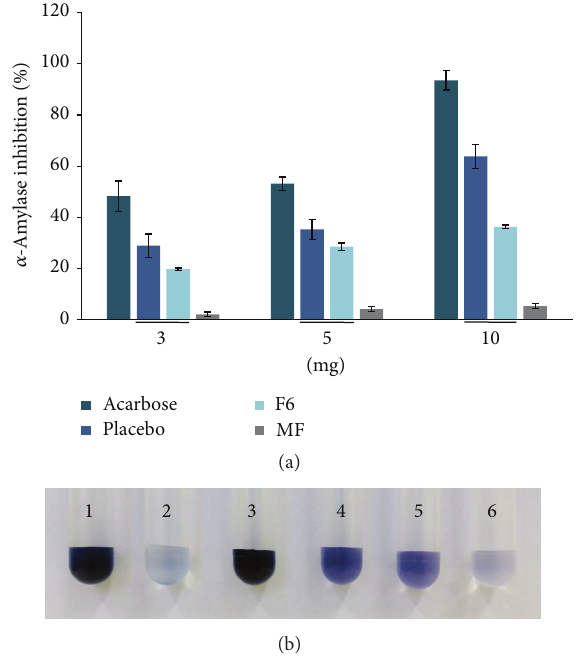
Figure 5: The effect of microspheres placebo (placebo), micro- spheres formulation F6 (F6), and metformin hydrochloride (MF) in an amount corresponding to its loading in microspheres for- mulation F6 (2.27 mg, 3.78 mg, and 7.56 mg, resp.) on the in vitro 𝛼 -amylase inhibition (a), and representative images of reactive mixture: without 𝛼 -amylase (1) , with 𝛼 -amylase (2) , with acarbose (3) , with microspheres placebo (4) , with microspheres formulation F6 (5) , and with 7.56 mg of pure metformin hydrochloride (in an amount corresponding to its loading in microspheres formulation F6) (6) (b), 𝑛 = 3